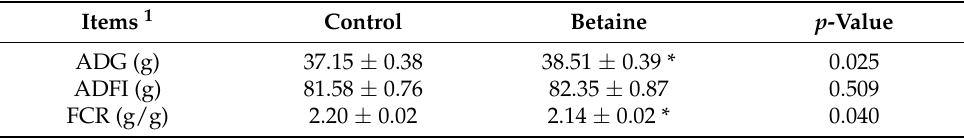
Table 3. Effect of betaine on growth performance of broilers from 1 to 52 d of age. Items 1